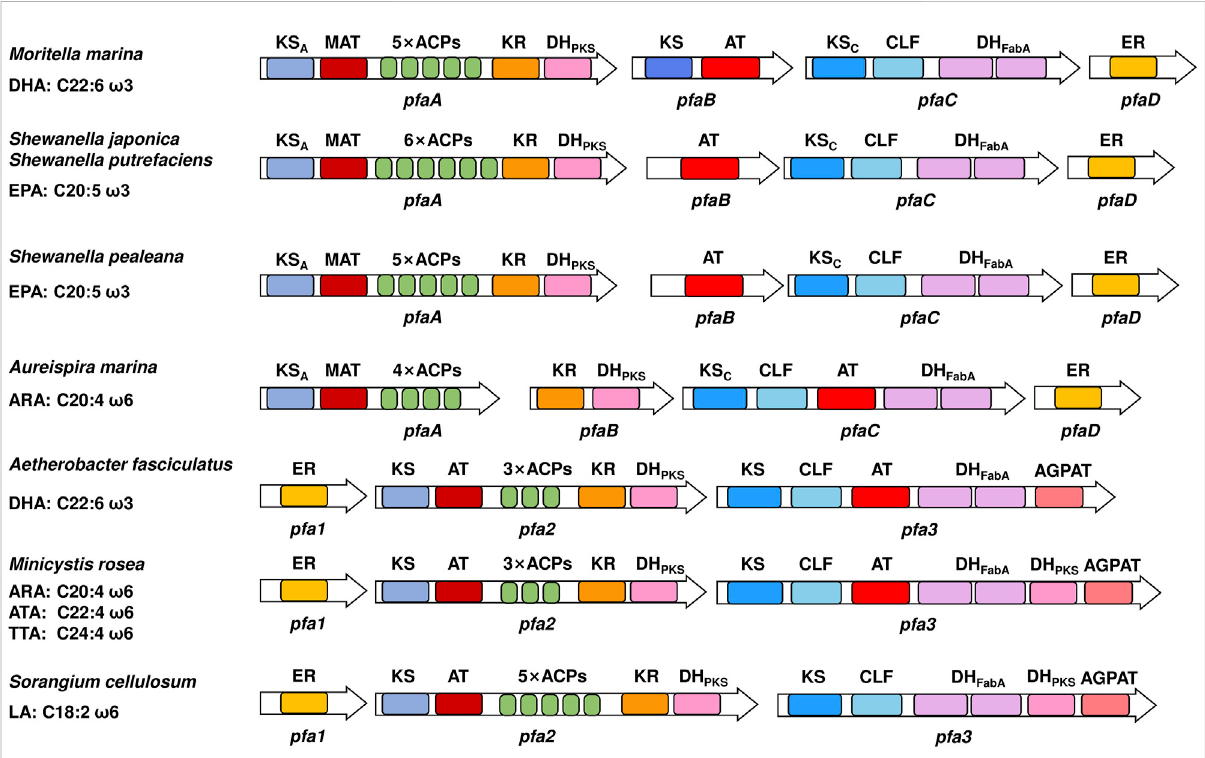
FIGURE 3 Domain organizationsofseveralprokaryoticPUFAsynthases.Ontheleftarethenative sourcesandmainproducts ofPUFAsynthases.Different domains are indicated by colors. ACP, acyl carrier protein domain; MAT, malonyl-CoA: ACP transacylase domain; KS, ketoacyl-ACP synthase domain;CLF,chainlengthfactordomain;KR,ketoacyl-ACPreductasedomain;DH PKS ,PKS-likedehydratasedomain; DH FabA ,FabA-likedehydratase domain; ER, enoyl-ACP reductase domain; AT, acyltransferase domain; AGPAT, 1-acylglycerol-3-phosphate O -acyltransferase domain. The subscripts A and C indicate that the corresponding domain is located in subunits A and C,